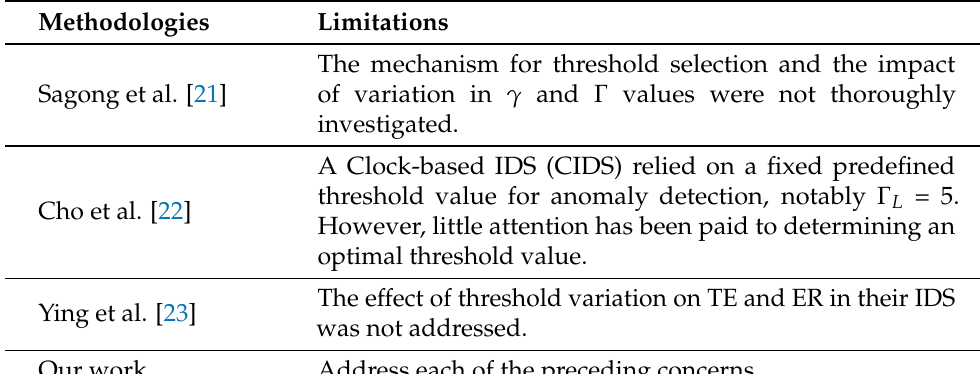
Table 8. Limitations of methodologies using threshold as parameter.